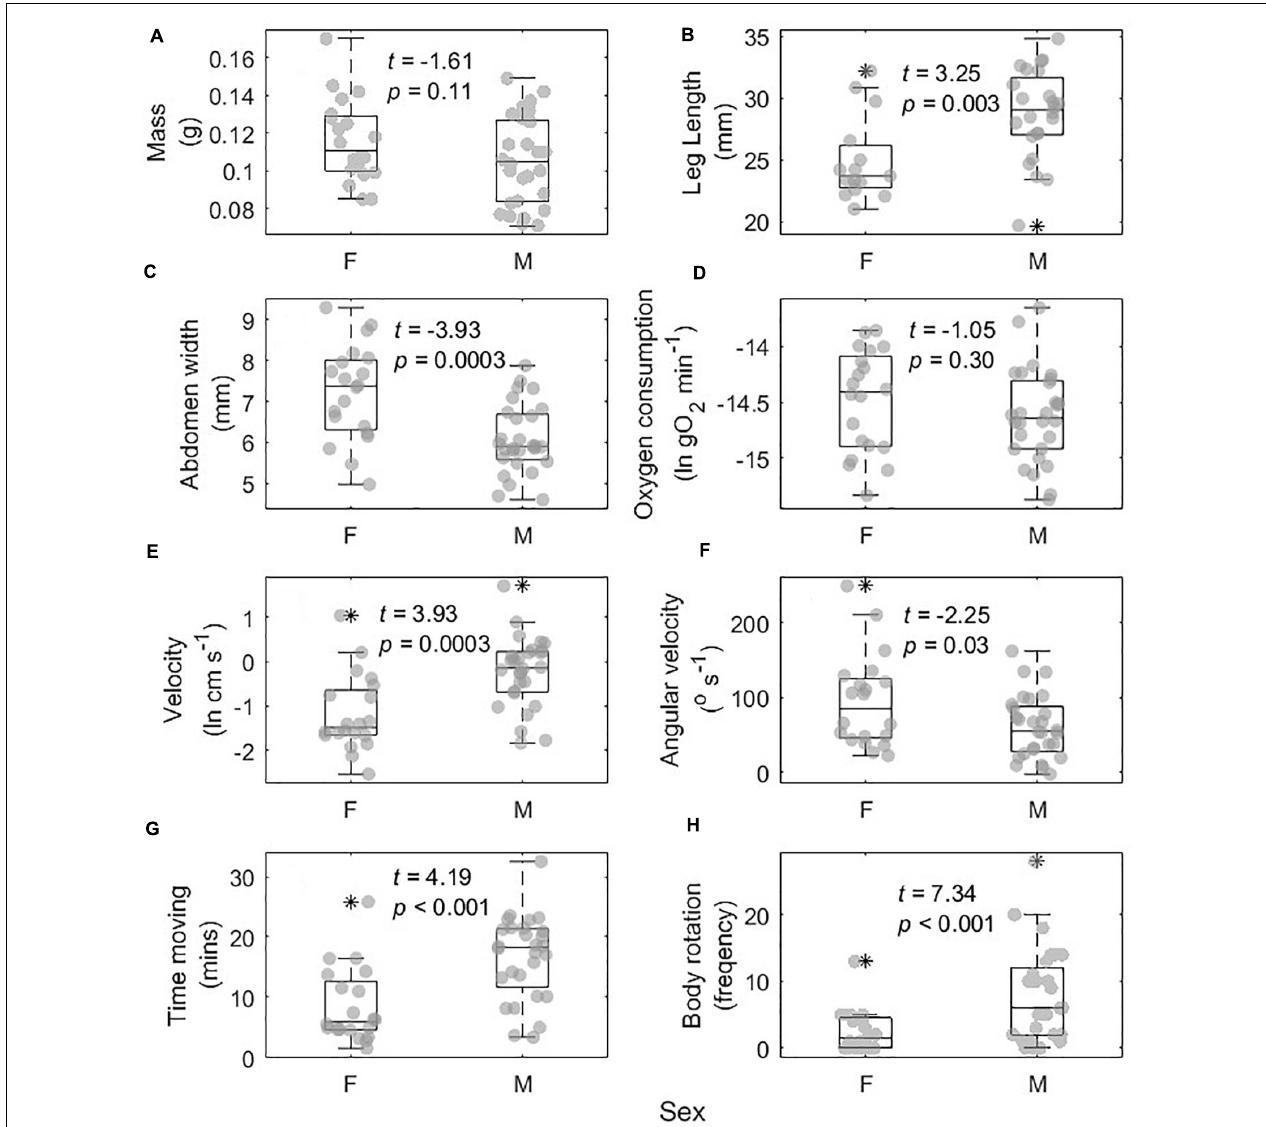
FIGURE 3 | Differences in morphological, physiological, and movement traits between 20 male (M) and 28 female (F) Schizocosa mccooki wolf spiders. Traits were body mass (A) , average leg length (B) , abdomen width (C) , oxygen consumption (D) , average velocity (E) , angular velocity (F) , amount of time spent moving (G) , and number of body rotations (H) . Jittered raw data overlap box plots showing the median and inner 50% of the data.